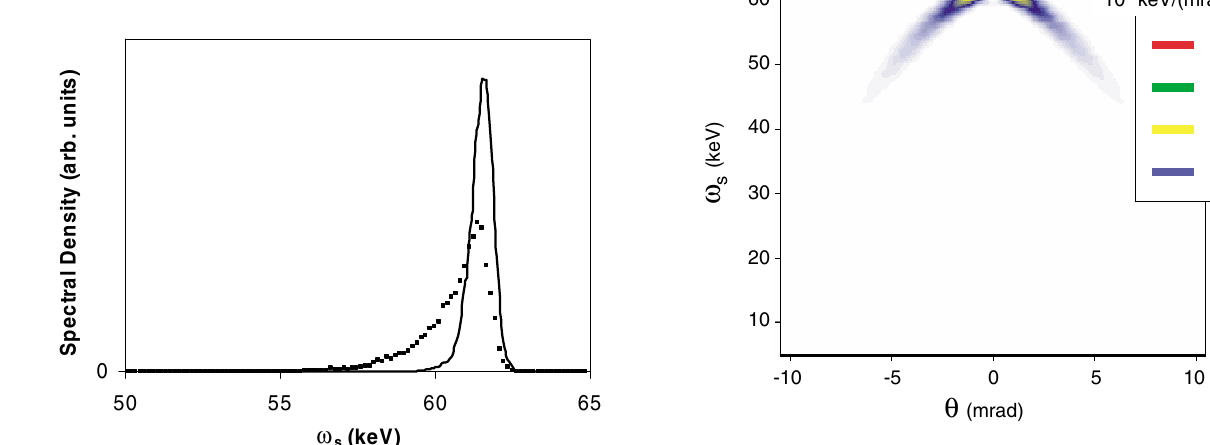
FIG. 9. On-axis x-ray spectrum resulting from a head-on collision of a 50 MeV electron beam with an 800 nm laser pulse for the case of an rms normalized emittance of 1 mm mrad (line) and 2 mm mrad